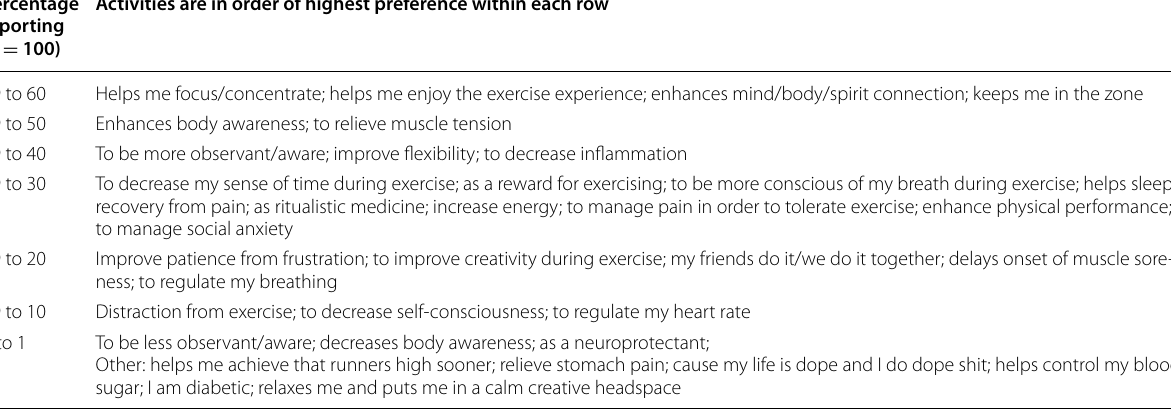
Table 2 Percent of participants reporting why they used cannabis while exercising